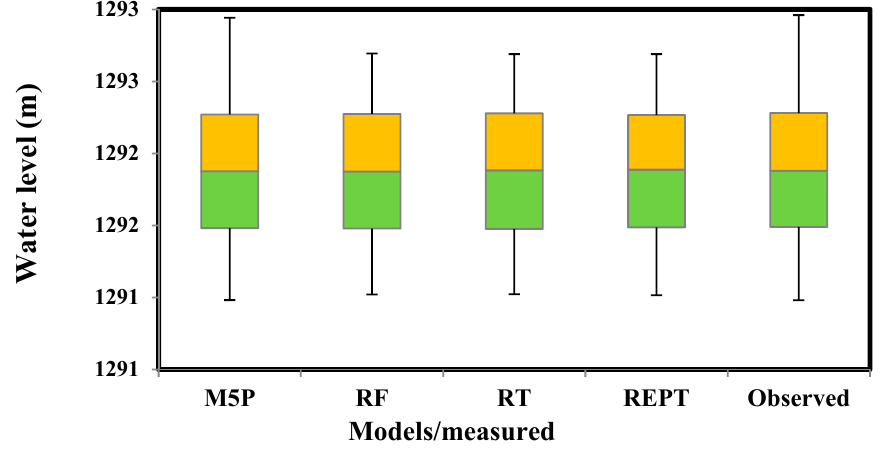
Figure 6. Boxplot of the models.